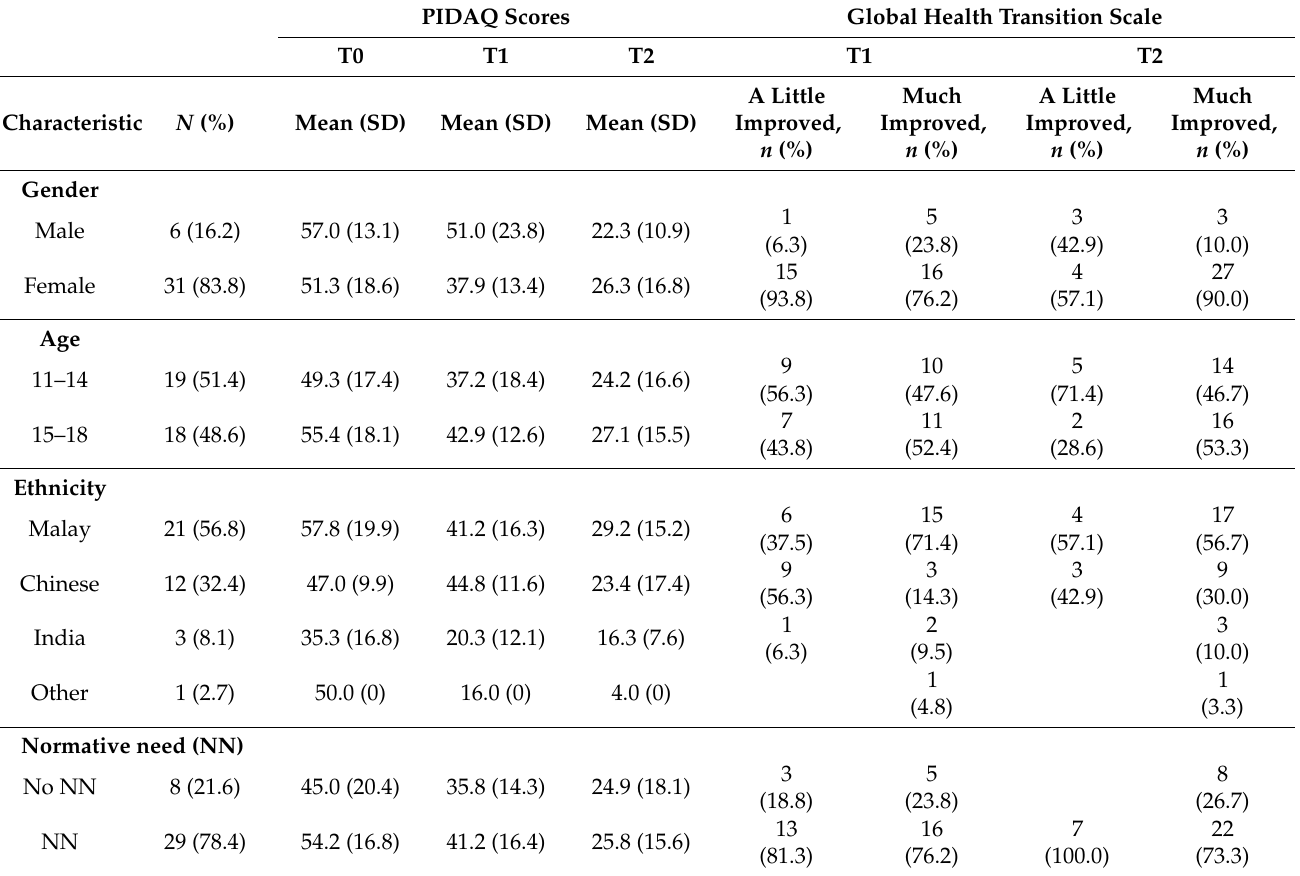
Table 1. Demographic characteristics of the Malaysian psychosocial impact of dental aesthetics questionnaire (PIDAQ) score and global health transition scale ( N =